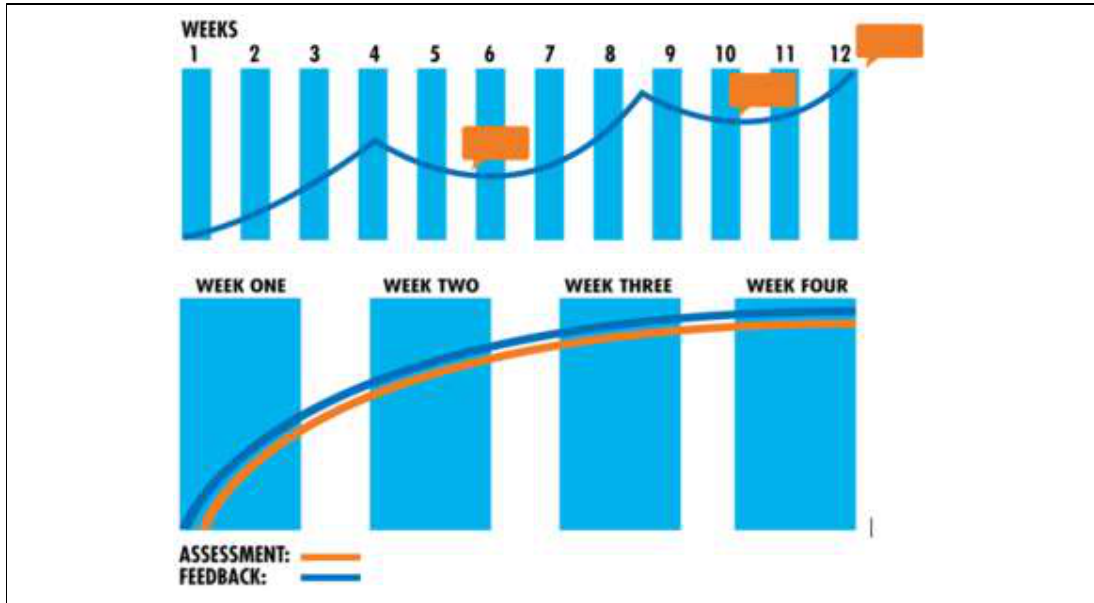
Figure 2 . Traditional 12-week versus block mode in assessment and